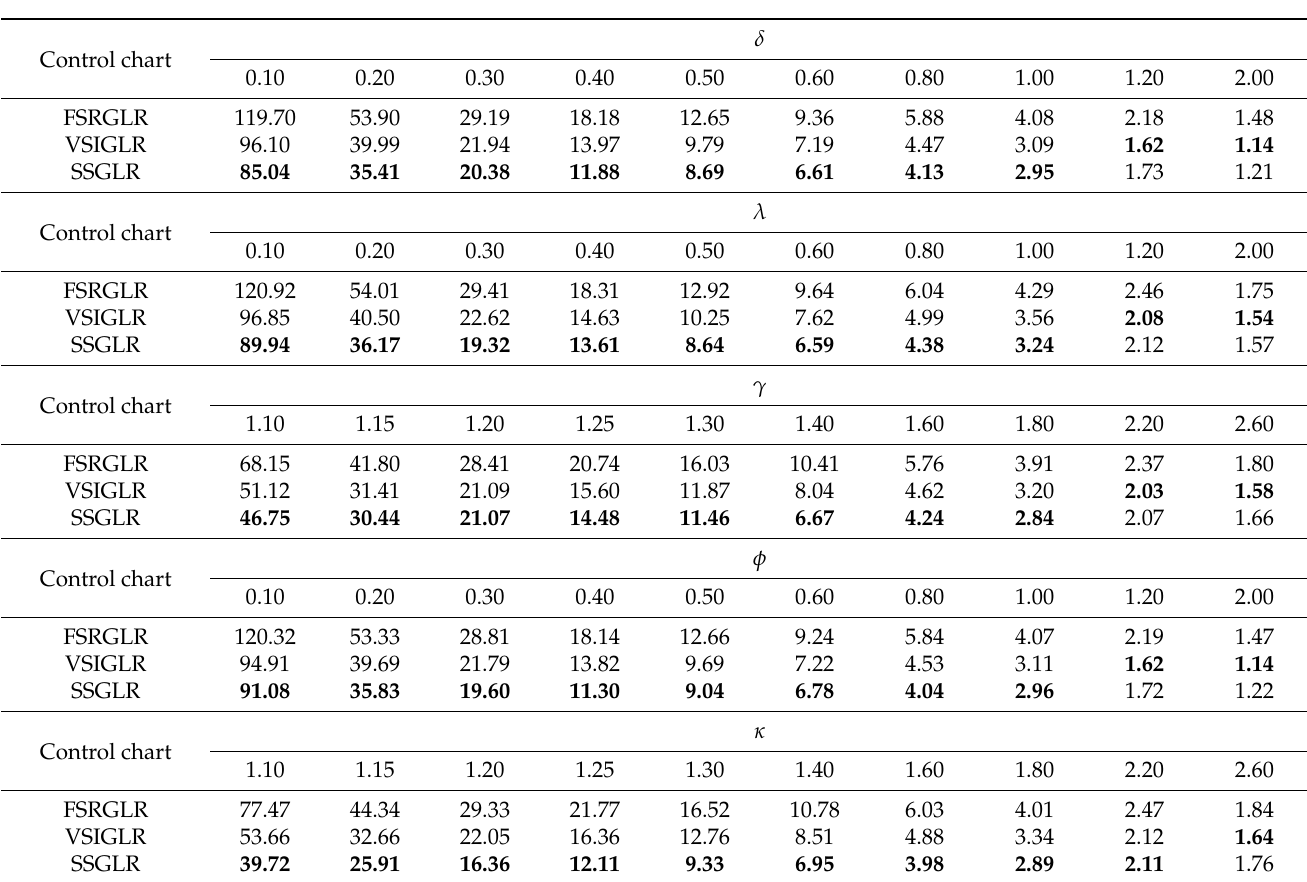
Table 2. The ATS 1 values for the FSRGLR, VSIGLR, and SSGLR control charts under the individual shifts ( m = 400 and ATS 0 =